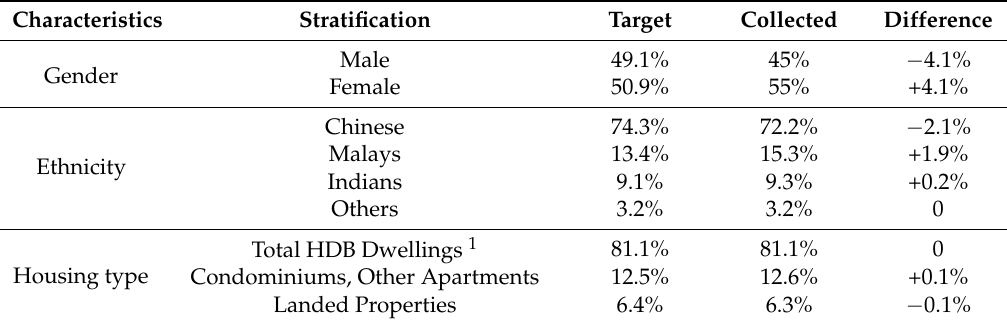
Table 1. Sampling stratification by demographic characteristics and housing